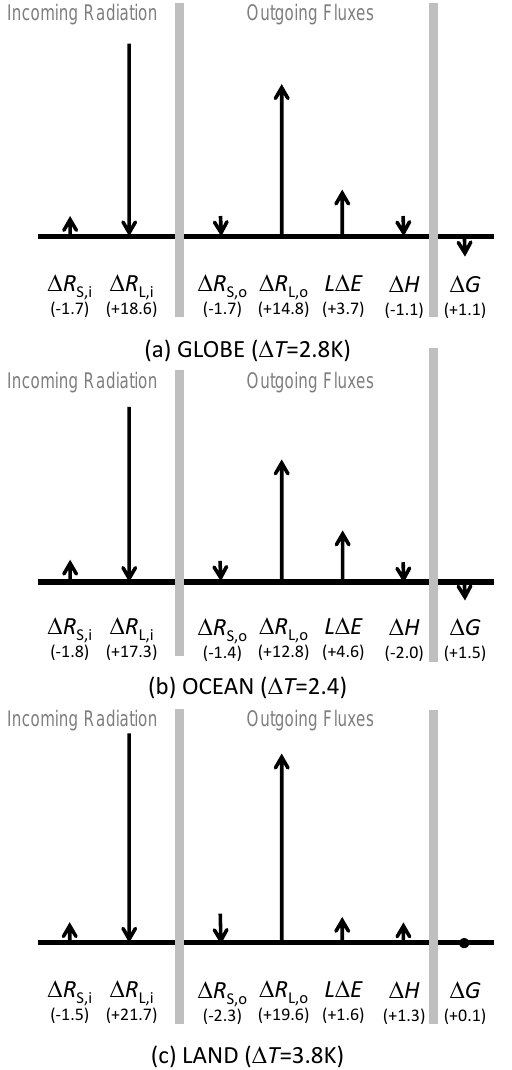
Fig. 5. Stylised diagram showing projected changes (2070–2099 less 1970–1999) in components of the surface energy balance (units: Wm − 2 ) over the (a) globe, (b) ocean and (c) land. Data are from Table 2. Projected changes in (left) incoming radiation (short-wave, 1R S,i ; long-wave, 1R L,i ) are separated from (mid- dle) changes in the outgoing radiative ( 1R S,o , 1R L,o ) and con- vective ( L1E , 1H ) fluxes and from (right) the rate of change in enthalpy ( 1G ). 1T (below each panel) denotes the surface temper- ature